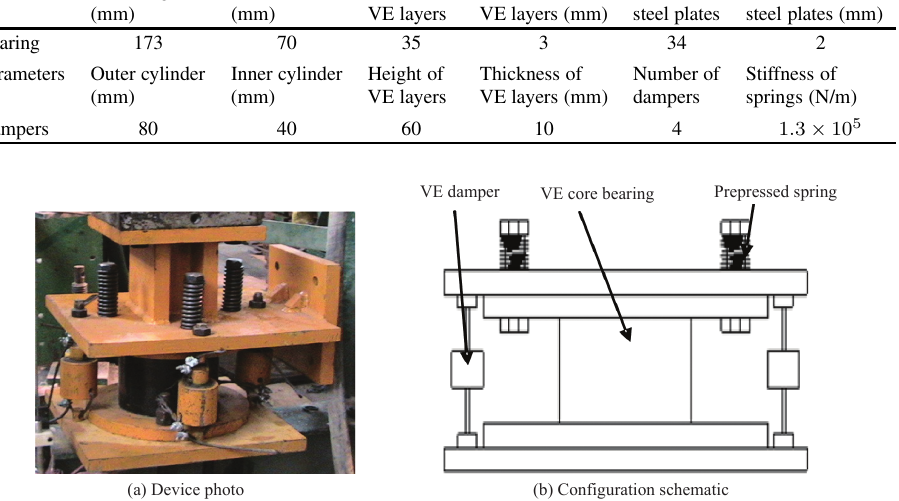
Fig. 1. Multi-dimensional earthquake isolation and mitigation